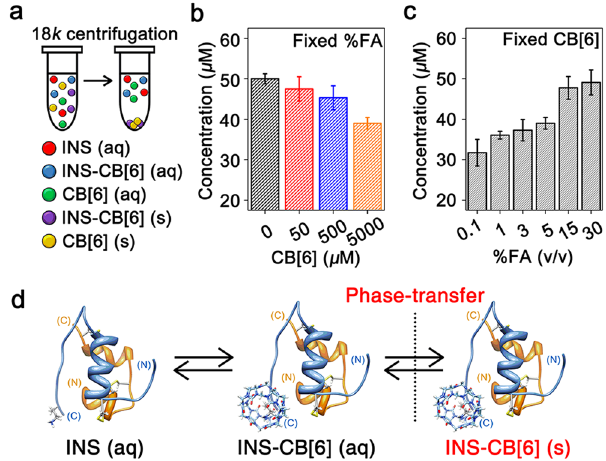
Figure 1. Phase transfer of INS by CB[6]. ( a ) Representation for centrifugation of an INS-CB[6] solution. ( b ) Concentration changes of INS in the supernatant with various amounts of CB[6] in a 5% FA solution. ( c ) Concentration changes of soluble INS in the supernatant with variable %FA with 5 mM CB[6]. ( d ) Phase transfer of INS between the soluble state and the insoluble